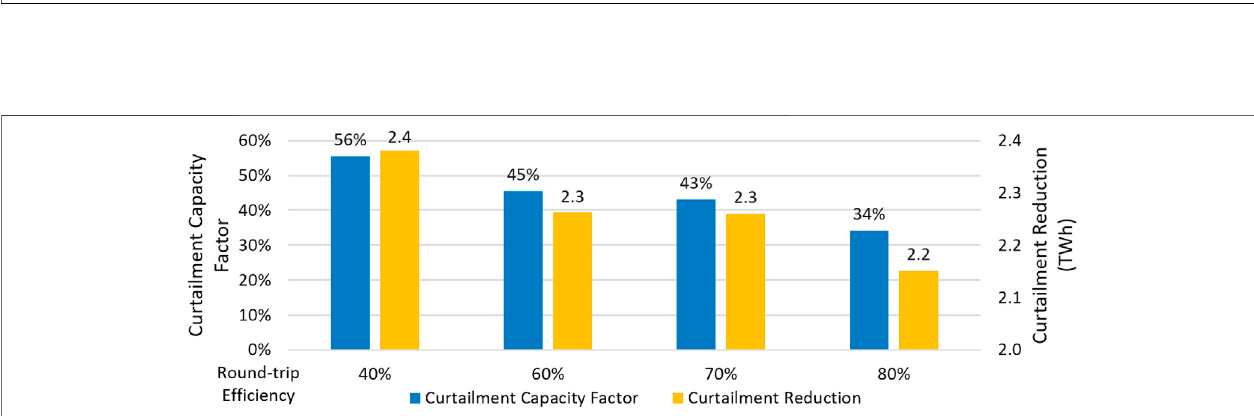
FIGURE 17 | The share of charging energy from otherwise curtailed variable renewable energy and curtailment reduction values associated with the maximum bene fi t long-duration energy storages including energy storages with (A) 40% round-trip ef fi ciency and 9-day duration, (B) 60% round-trip ef fi ciency and 24-day duration, (C) 70% round-trip ef fi ciency and 30-day duration, and (D) 80% round-trip ef fi ciency and 32-day duration.